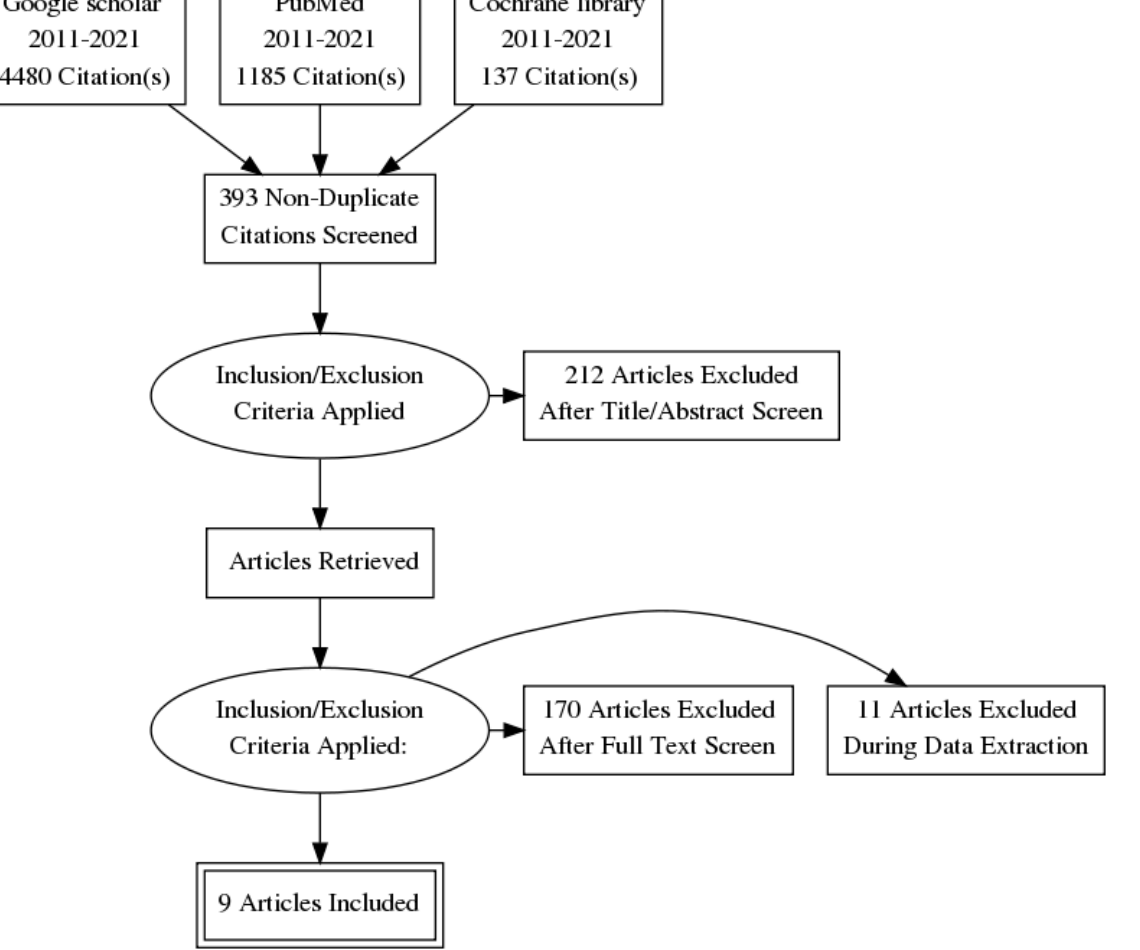
Figure 1. Studies selection diagram. Following text reading, 170 articles was excluded for the following reasons: other lesions not pancreatic, studies other than randomized clinical trial or insufficient data (inaccurate study population such as abdominal solid mass, sample size less than 30 patients, no data available on the diagnostic yield). After this step, 11 articles have been removed during the extraction phase of data, because they did not give the measurement of the diagnostic yield about sampling techniques in case of cancerous pancreatic lesions (only for the gathered solid pancreatic lesions involving, for example, pancreatic cysts and chronic pancreatitis).